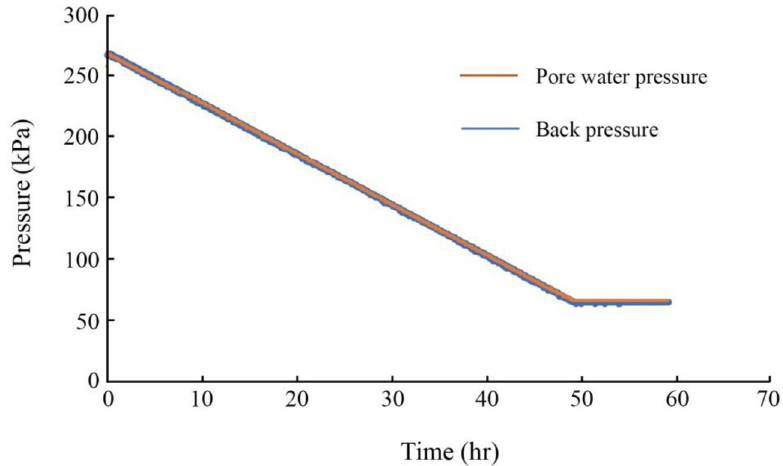
Fig 4. Change of back pressure and pore water pressure in the withdrawal process, taking sample 4 for example.